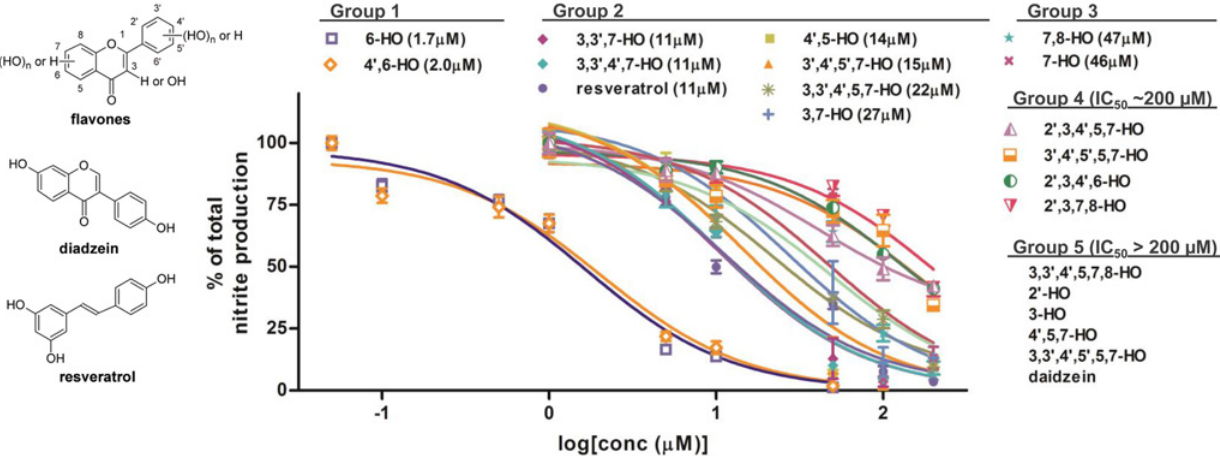
Fig 1. Anti-inflammatory activity of mono-, di- and polyhydroxylated flavones on the LPS-induced NO production in rat kidney mesangial cells. All of the hydroxylated flavones were abbreviated as the positions of hydroxyl groups followed by — HO. The total production of nitrite in the treatment media was measured with Griess assay at 48 h post 10 ng/mL LPS stimulation. The nitrile level in the LPS treatment alone was used as 100%, and IC 50 values were obtained using the dose-response analysis provided by the Graphpad Prism software as shown in parenthesis. Compounds of group 5 with IC 50 > 200 μ M were not shown in the